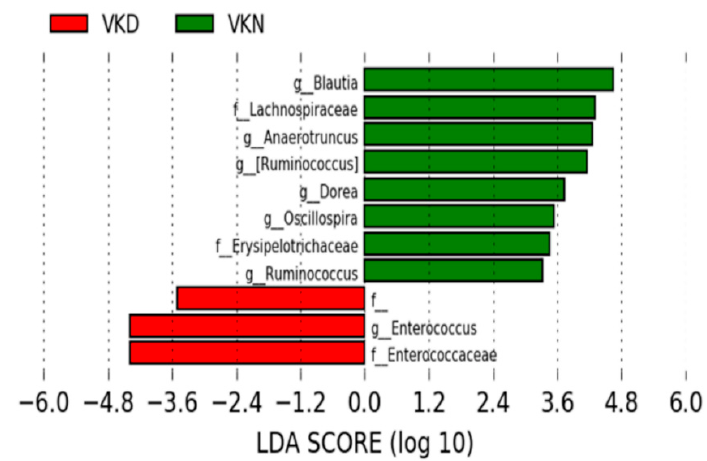
Figure 8. Gut microbiota at the genus level in the vitamin K-satisfactory state. The enriched gut microbiota at the genus level were identified by linear discriminant analysis (LDA) effect size (LEfSe). The operational taxonomic units (OTUs) with an LDA score of >2 are shown. VKN, vitamin K-normal group; VKD, vitamin K-deficient group; LDA, linear discriminant analysis; f__, order__ Clostridiales ;familty__; f, family; g, genus.